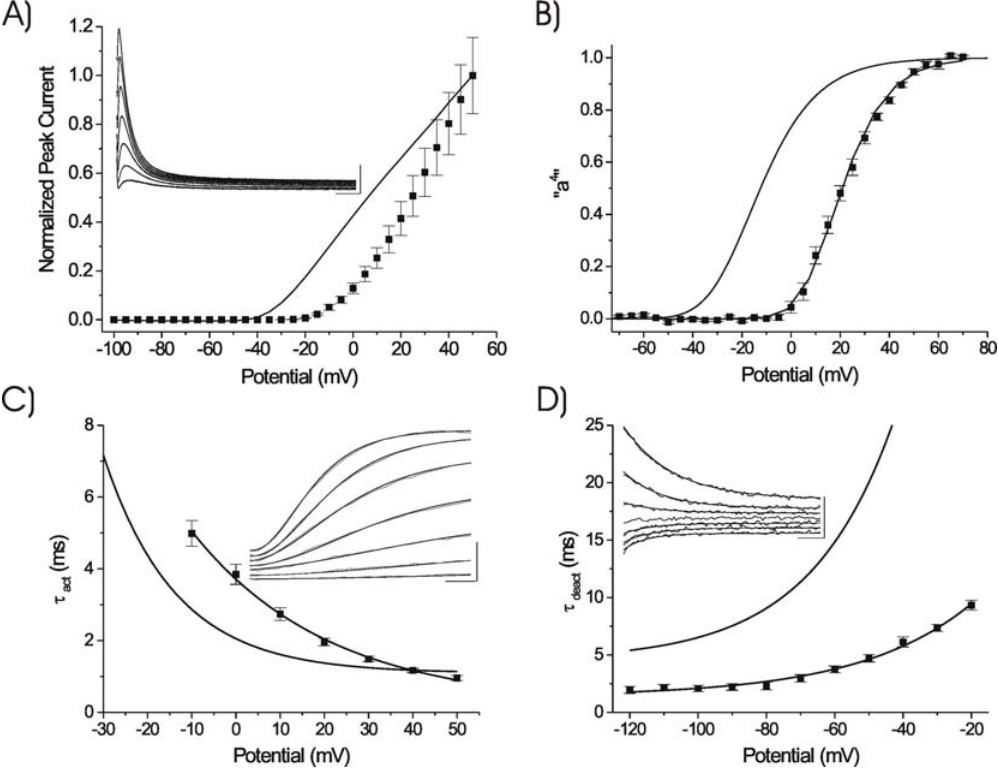
Figure 1. Activation and Deactivation Characteristics. A) Main Panel : Comparison of normalized (peak values at + 50 mV) mean peak transient I–V relationships for V287R (n=8) and WT Kv4.3, from [16]. HP= 2 100 mV, currents elicited by one second depolarizing pulses, and mean peak transient current defined as peak current minus residual current at the end of the depolarizing pulse. V287R mean peak current amplitude at + 50 mV=903 6 141 nA. Inset : Representative current waveforms for V287R elicited in response to depolarizing voltage clamp pulses applied from 2 10 mV to + 50 mV, 10 mV increments. Calibration bar: 200 nA, 50 ms. B) Mean steady-state activation curve ‘‘a 4 ’’ fit as a fourth order Boltzmann relationship